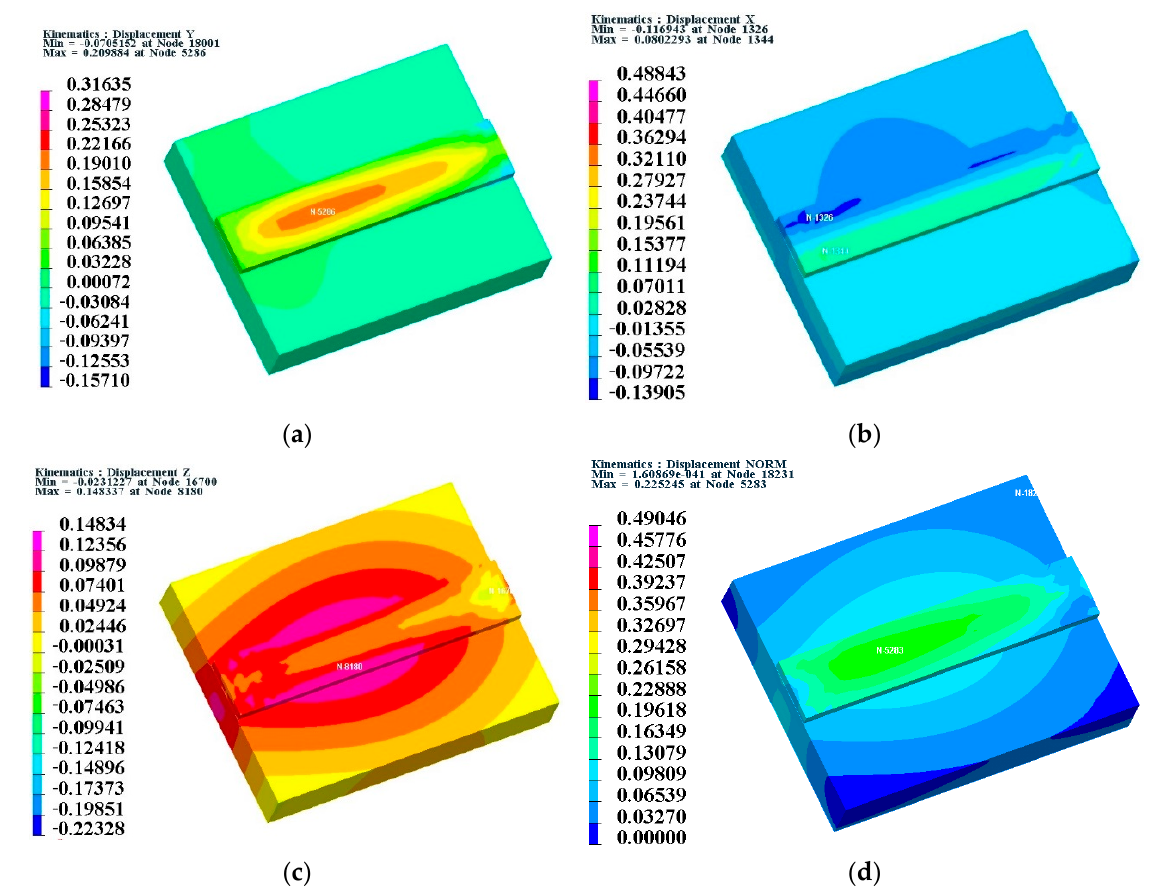
Figure 16. Residual deformation diagram of all directions and the whole after welding. ( a ) Y direction (surfacing direction); ( b ) X direction (width direction); ( c ) Z direction (thickness direction of surfacing layer); ( d ) Overall deformation.